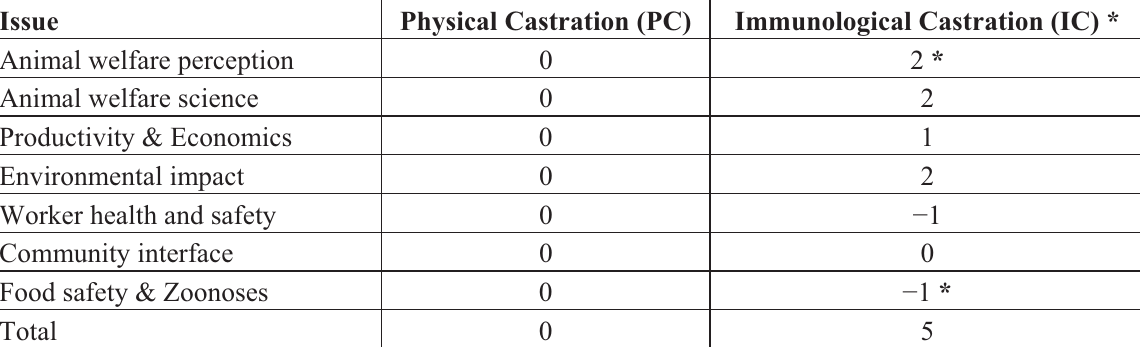
Table 4. Comparison of selected methods of castration using a sustainability matrix. This table applies to countries where pigs are marketed at relatively heavy weights (over 110 kg live